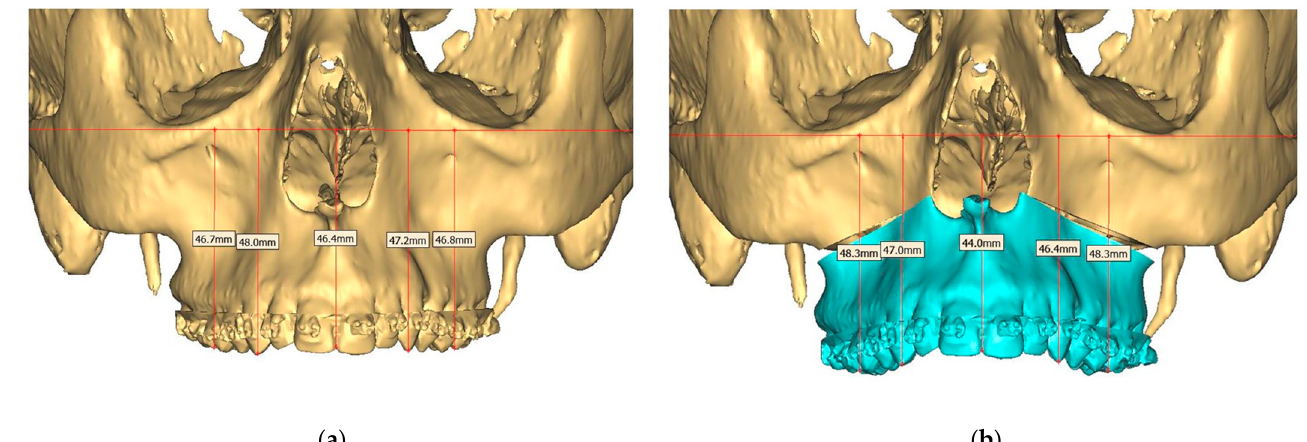
Figure 8. ( a ) Pre-operative and ( b ) Planned Maxilla.